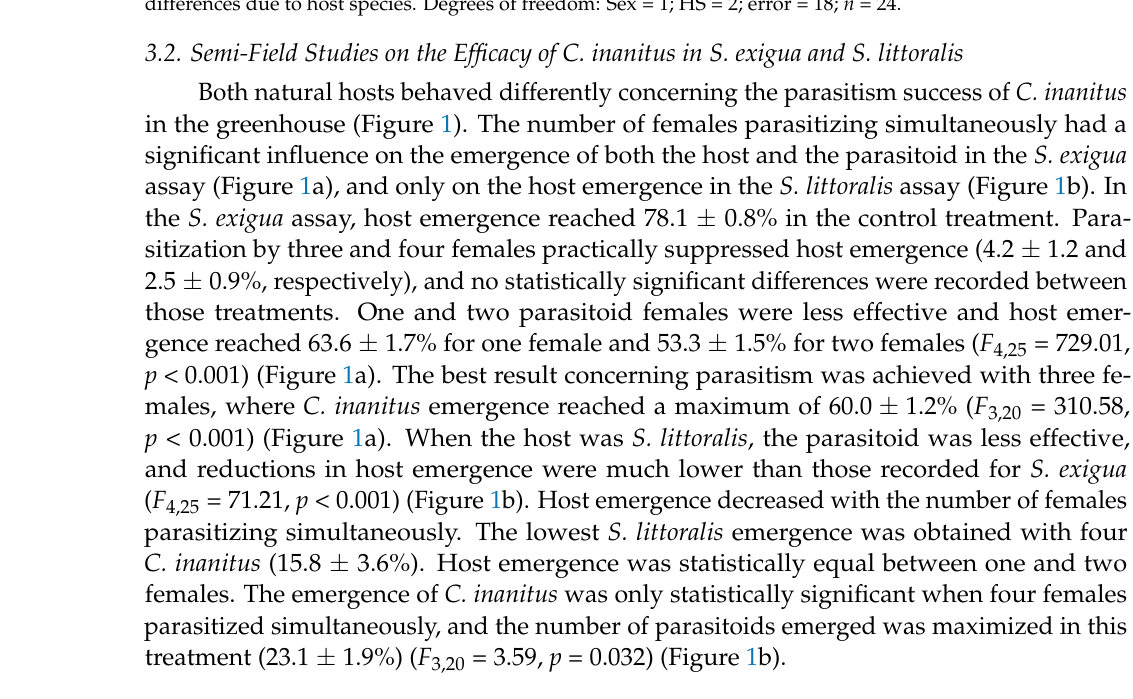
Figure 2. Developmental mortality of Spodoptera inside the greenhouse, depending on the number of Chelonus inanitus females parasitizing simultaneously. Data (mean ± SEM) are percentages, ac- cording to the 60 host eggs offered to the parasitoid. Letters stand for significant differences among treatments ( p < 0.05). 4. Discussion Many parasitoids of eggs can be successfully produced in factitious hosts at a lower cost than when they are reared in natural hosts, because less manpower and a cheaper diet are required. In koinobiont parasitoids with facultative arrhenotoky reproduction, females can potentially control the sex of the offspring by deciding if they release or not sperm as eggs pass down the oviduct (fertilized eggs developed into females and non- fertilized eggs into males). In addition, egg-larval koinobiont parasitoids such as C. inani- tus need live host juveniles to complete their development. Therefore, there are two main